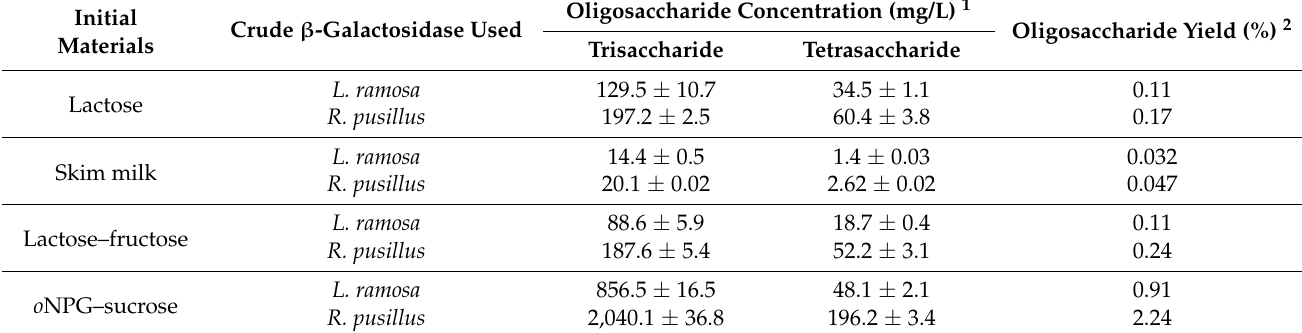
Table 2. Concentration and yield of oligosaccharides obtained with L. ramosa and R. pusillus β -galactosidase extracts (about 2400 units) on different initial